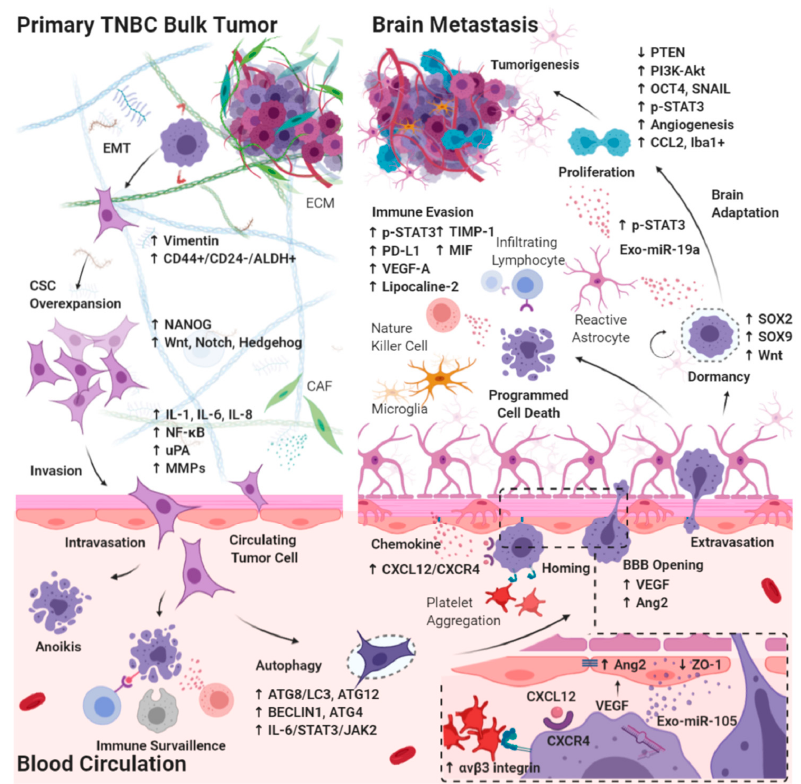
Figure 1. Diagram of molecular pathways involving CSC during the development of BM-TNBC. CSCs in TNBC bulk tumor must invade through the extracellular matrix in primary bulk tumors, intravasate blood vessels, survive the turbid flow of the blood circulation in vasculature, escape from immune surveillance, arrest in the capillary bed, and extravasate blood brain barrier (BBB), with subsequent tumor growth into brain metastasis involving microenvironmental niche–dormant cell interactions, neuroinflammatory cascades, and neovascularization. EMT: epithelial–mesenchymal transition; CAF: cancer-associated fibroblast; IL: interleukin; ATG: autophagy-related protein; VEGF: